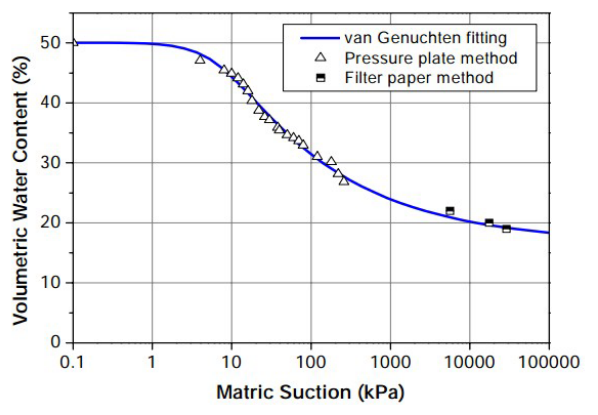
Fig. 10. Soil water characteristic curve in study area.